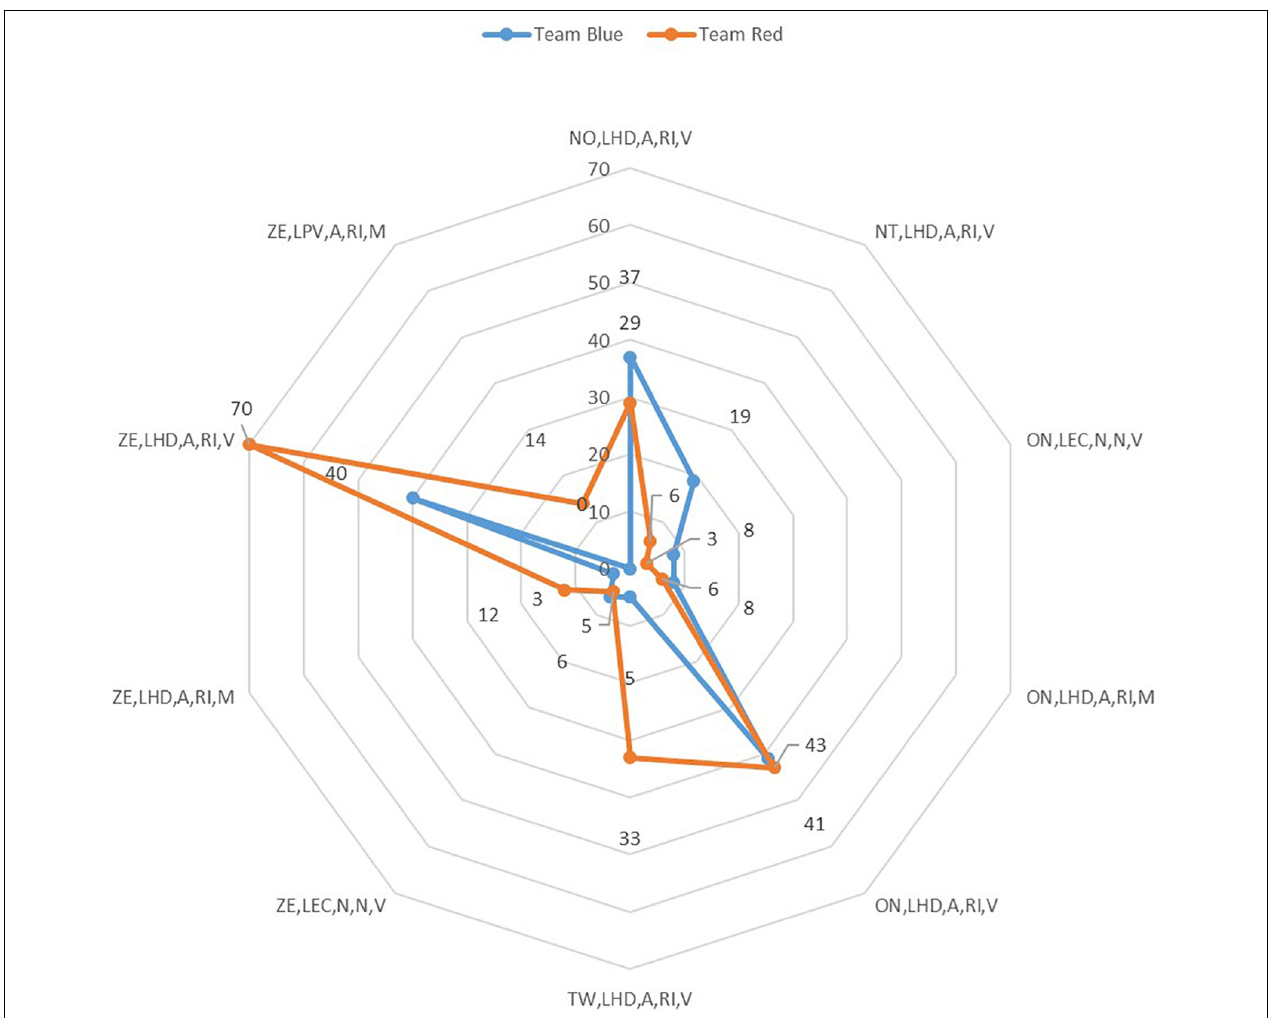
FIGURE 8 | Marro360 ◦ strategic chains used by the two teams in the role of